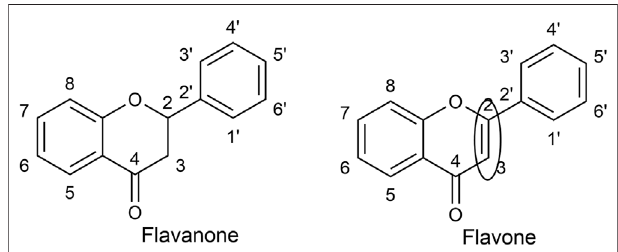
FIGURE 4 | The double bond between C2 and C3 makes it possible to distinguish fl avones from fl avanones.